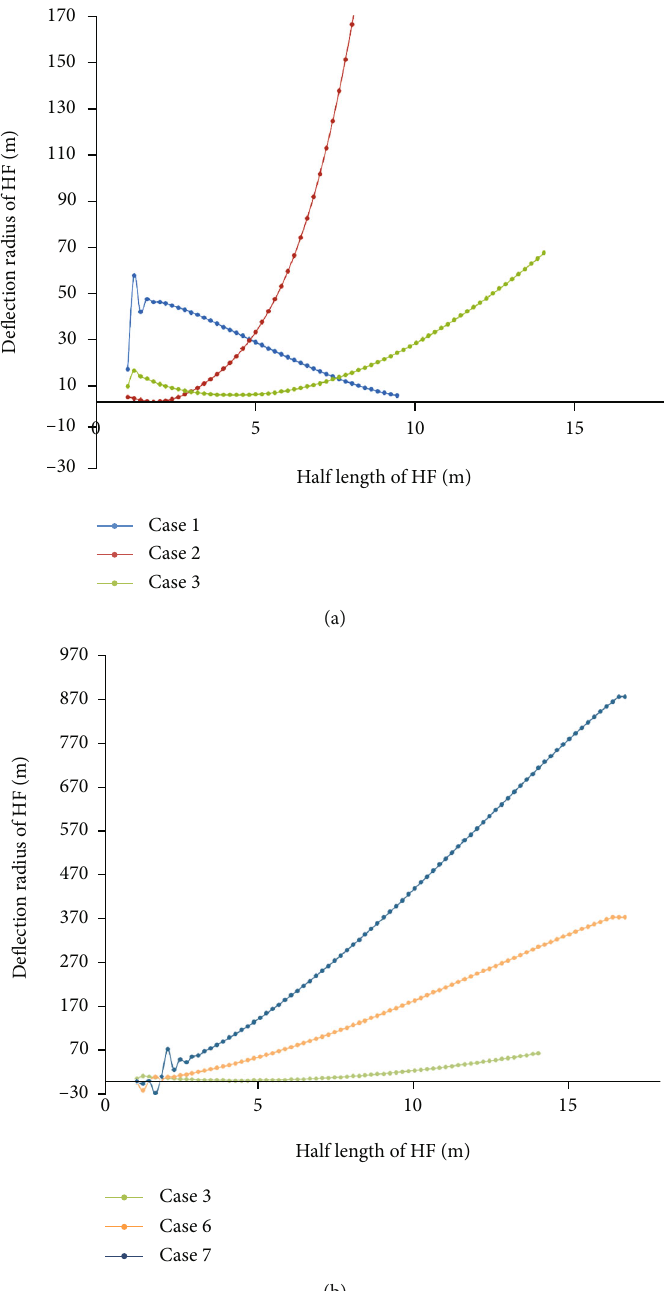
Figure 7: The fracture curvature radius of the HF. (a) Under di ff erent stress di ff erences. (b) Under di ff erent perforation